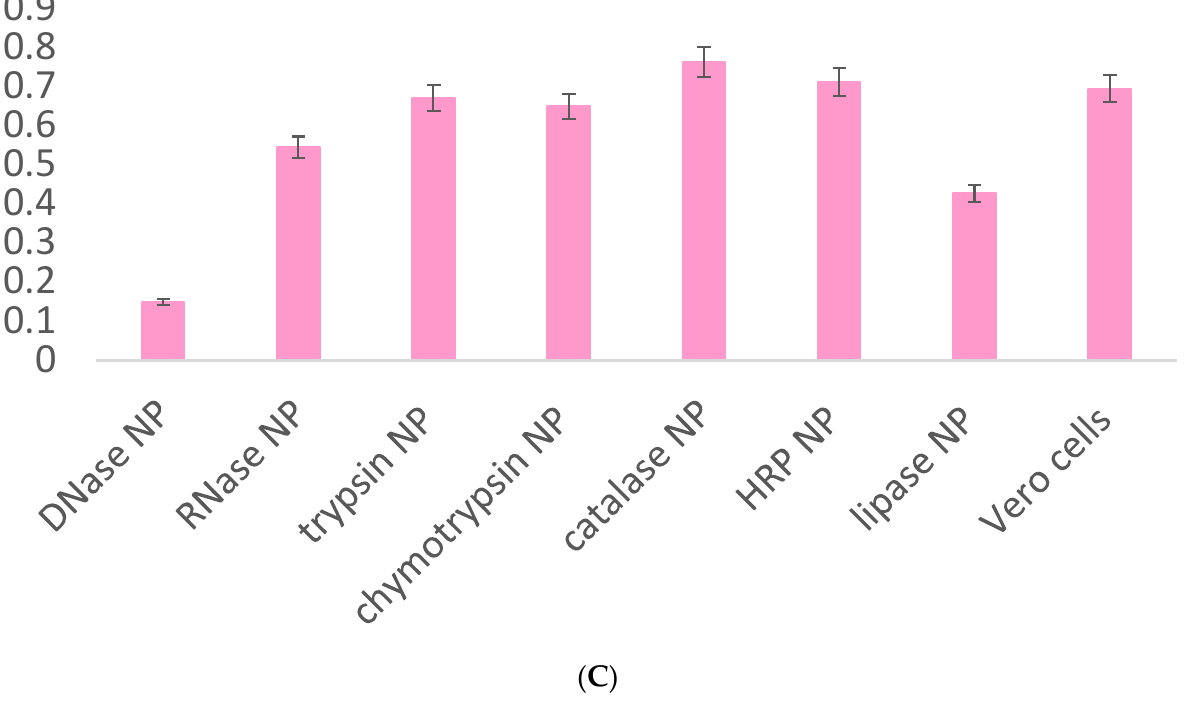
Figure 10. Cytotoxicity of the ENP for HEp-2, HT-29 and Vero cells in the presence of ENP at 3 days posttreatment. Part ( A ) corresponds to HEp-2 cells, part ( B )—HT-29 cells, part ( C )—Vero cells.